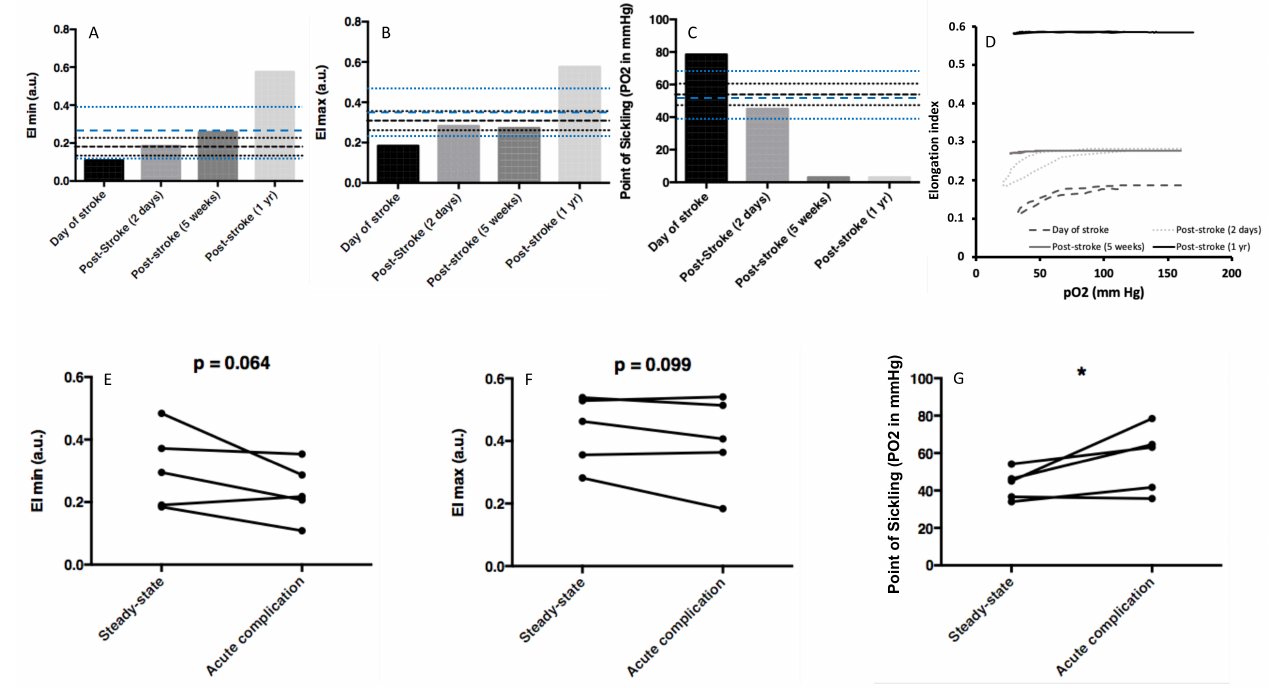
Figure 3. ( A – C ) Evolution of oxygen gradient ektacytometry parameters in a patient hospitalized for stroke event and then treated by chronic exchanged transfusion (5 weeks and 1 year after the event). ( A ) EImin; ( B ) EImax; ( C ) PoS;. A dashed bold black line indicates the mean, and thin black dashed lines indicate confidence intervals, calculated in the SS patients without any transfusion, older than 5 years old, not on hydroxyurea, and at steady state. A dashed bold blue line indicates the mean, and thin blue dashed lines indicate confidence intervals, calculated in the SS patients without any transfusion, younger than 5 years old, not on hydroxyurea, and at steady state. ( D ) Oxygenscan curves at the time of blood sampling in the patient who had a stroke event. ( E – G ) Comparisons of oxygenscan parameters between steady state and acute complication in 5 SS patients. ( E ) EImin; ( F ) EImax; ( G ) PoS. Significant difference: * p <